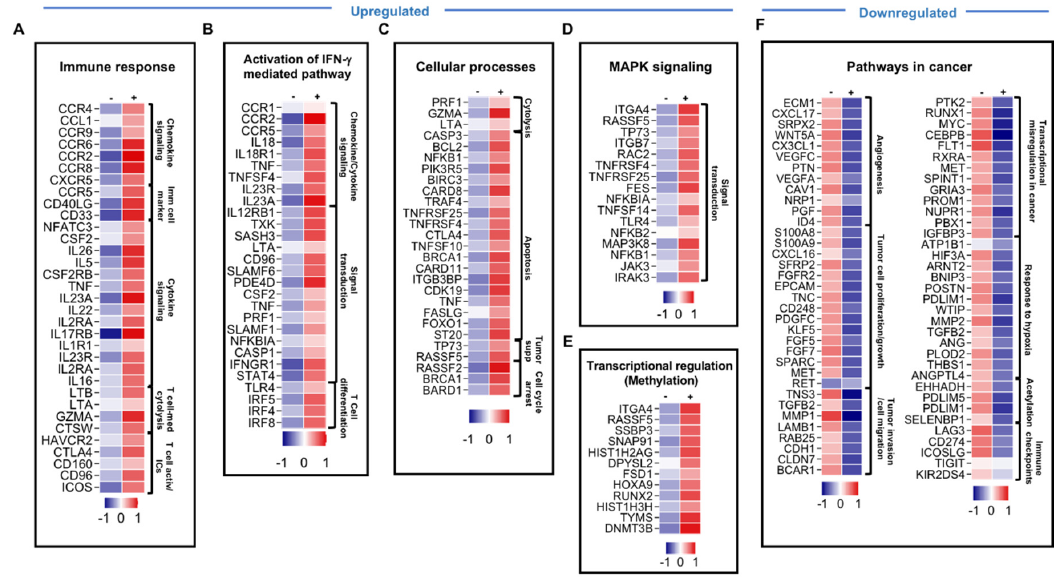
Figure 2. Di ff erential gene expression of breast tumor-infiltrating immune cells in response to pembrolizumab treatment. Heatmaps show the Z-score calculated from the transcript per million (TPM) of each gene to compare the expression level in tumor-infiltrating immune cells treated with anti-PD-1 vs. non-treated cells. Each column represents a sample pooled from two explant cultures either treated or untreated, and each row represents the Z-score for mean expression obtained from two explant cultures (patients #57 and 59). The Z-score for mean expression level of each gene is depicted according to color scale. The functional categorization of top significantly upregulated and downregulated genes (with a fold change of > 2 and p value < 0.05 cuto ff s) from CLC analysis were analyzed separately through DAVID platform. Genes involved in immune response ( A ), the activation of the IFN- γ -mediated signaling pathway ( B ), cellular processes ( C ), MAPK signaling ( D ), and genes related to transcriptional regulation via methylation ( E ) were upregulated in response to anti-PD-1, while genes in cancer-related pathways ( F ) were downregulated. Table 1. Differentially expressed immune checkpoints (receptors and ligands) in tumor-infiltrating immune cells from breast tumor explants in response to anti-PD-1, PD-L1, or anti-TIM-3 compared to non-treated cells.